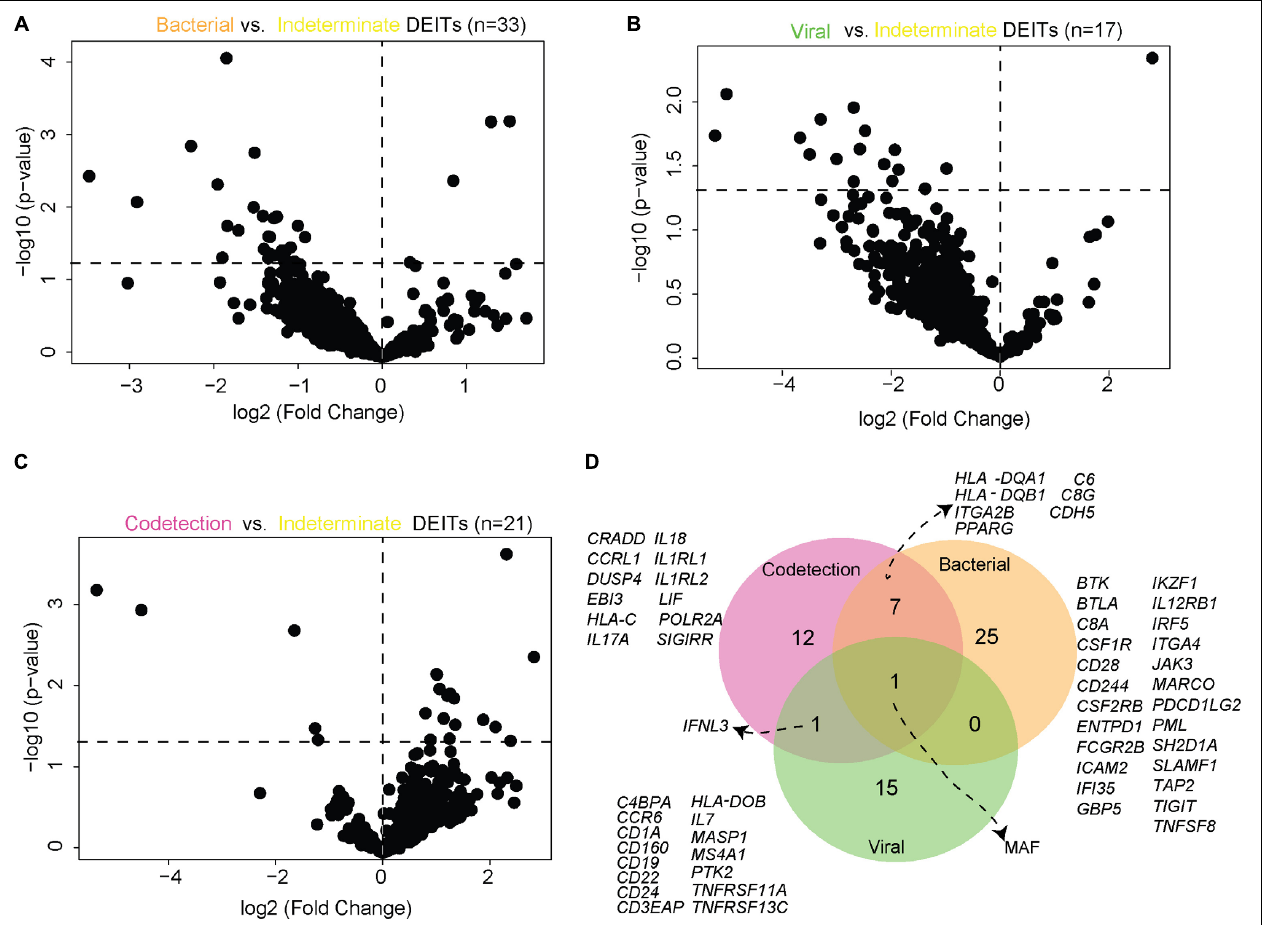
FIGURE 5 | Differentially expressed immune transcripts in nasopharyngeal aspirates of children with symptomatic ARI. “Volcano plots” of statistical significance against fold change between NPAs harboring microbial load [ (A) , bacterial; (B) , viral; and (C) , codetection] and NPAs characterized as “Indeterminate,” demonstrating the number of differentially expressed immune genes. (D) Venn diagram depicting the differentially expressed genes observed in each